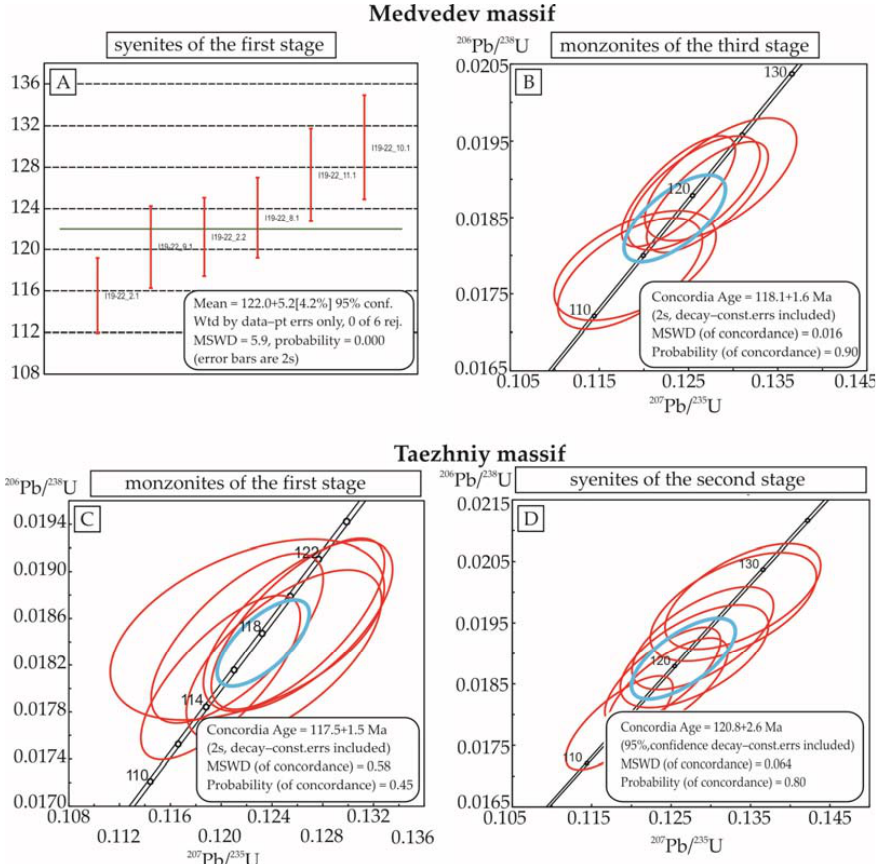
Figure 5. Age data of Medvedev and Taezhniy igneous rocks: ( A ) results of weighted mean 207 Pb/ 235 U age Ma of zircons from igneous rocks of first phase of Medvedev massif; ( B ) concordia diagram and weighted mean 207 Pb/ 235 U for sample I19 ‐ 15(n = 6); ( C ) concordia diagram and agram and weighted mean 207 Pb/ 235 U for sample I19-15(n = 6); ( C ) concordia diagram and weighted mean 207 Pb/ 235 U for sample I19 ‐ 24(n = 6); ( D ) concordia diagram and weighted mean 207 Pb/ 235 U for sample I19 ‐ 27(n = 7). Data point error ellipses are 2 σ .